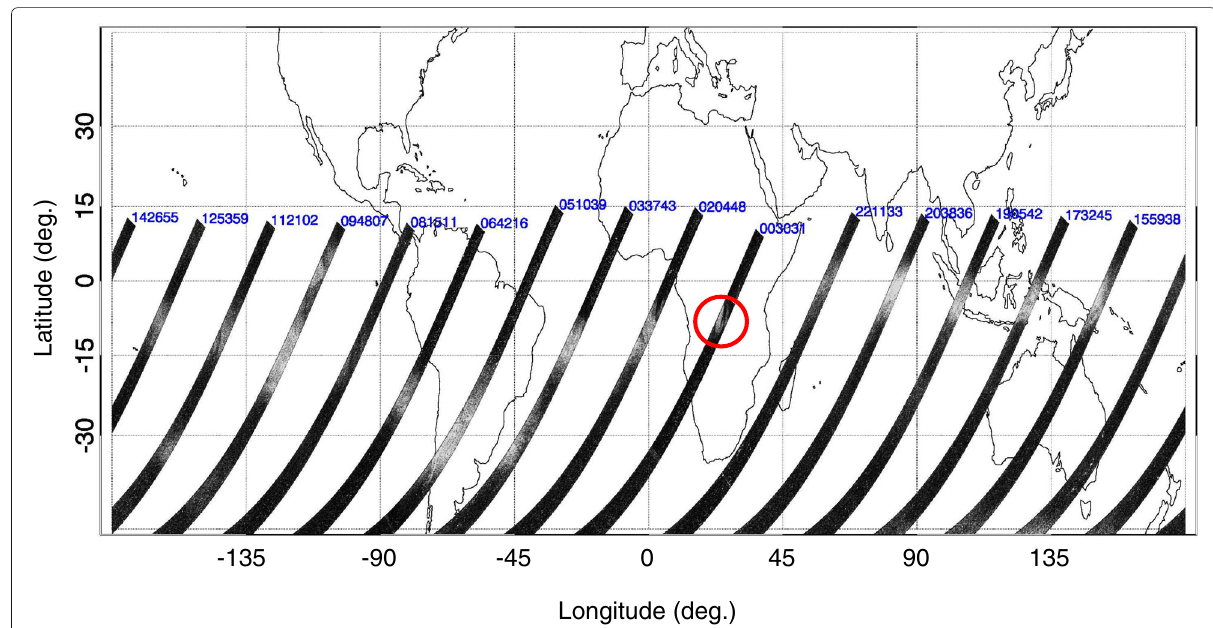
Fig. 5 The airglow images along the ISS-tracks obtained on 15 July 2013. The blue numbers indicate the end time of the observations of each